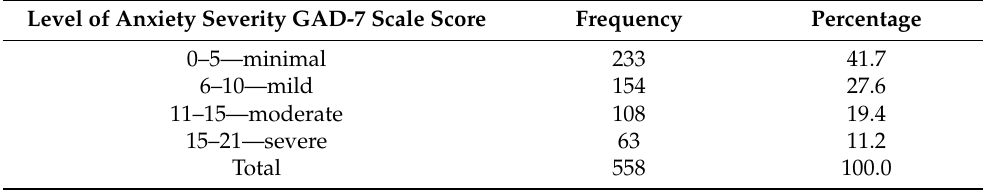
Table 4. The Generalized Anxiety Disorder Scale-7 (GAD-7) (Spitzer et al., 2006) [40].